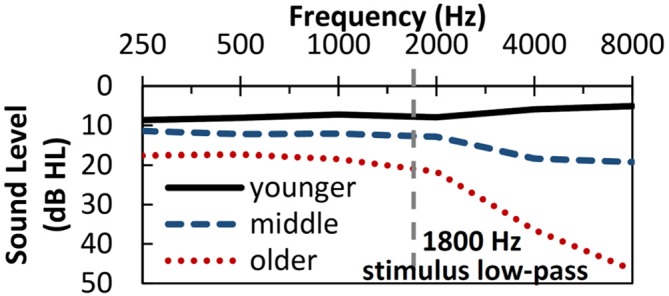
Mean audiogram for listeners in each of the three age groups in the test ear (right). Dashed vertical line represents low-pass filter cut-off frequency applied to the vowel stimuli.